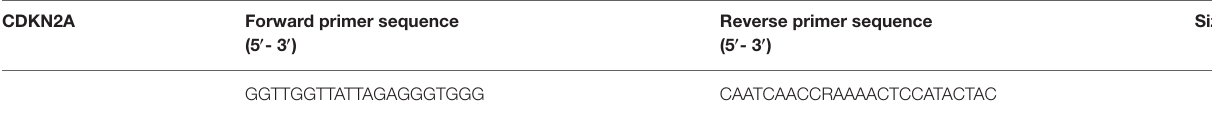
Reverse primer sequence (5 ′ - 3 ′